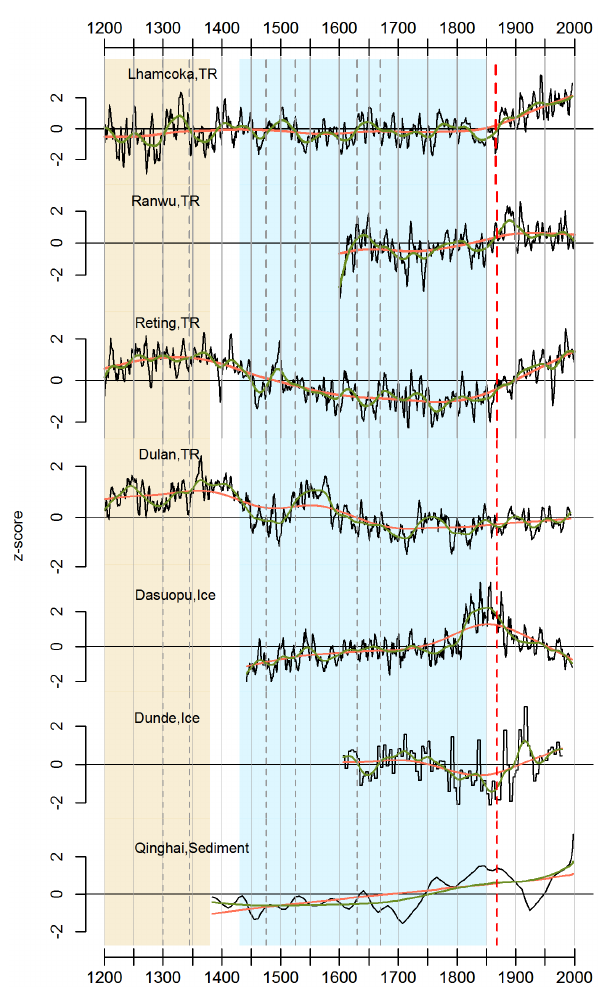
Figure 6. Multiproxy comparison of tree-ring data (TR), ice core, and lake sediment data. TR: Lhamcoka, this study; Ranwu, Liu et al., 2013; Reting, Grießinger et al., 2011; Dulan, Sheppard et al., 2004. Ice: Dasuopu and Dunde, Thompson et al., 2000. Sediment: Qinghai, Xu et al., 2006a. Locations of the several proxies are shown in Fig. 1. Z-scores were derived from raw proxy data and not from reconstructions. High positive Z-scores indicating dry condi- tions for TR and sediment records, whereas high Z-scores of ice accumulations represent humid